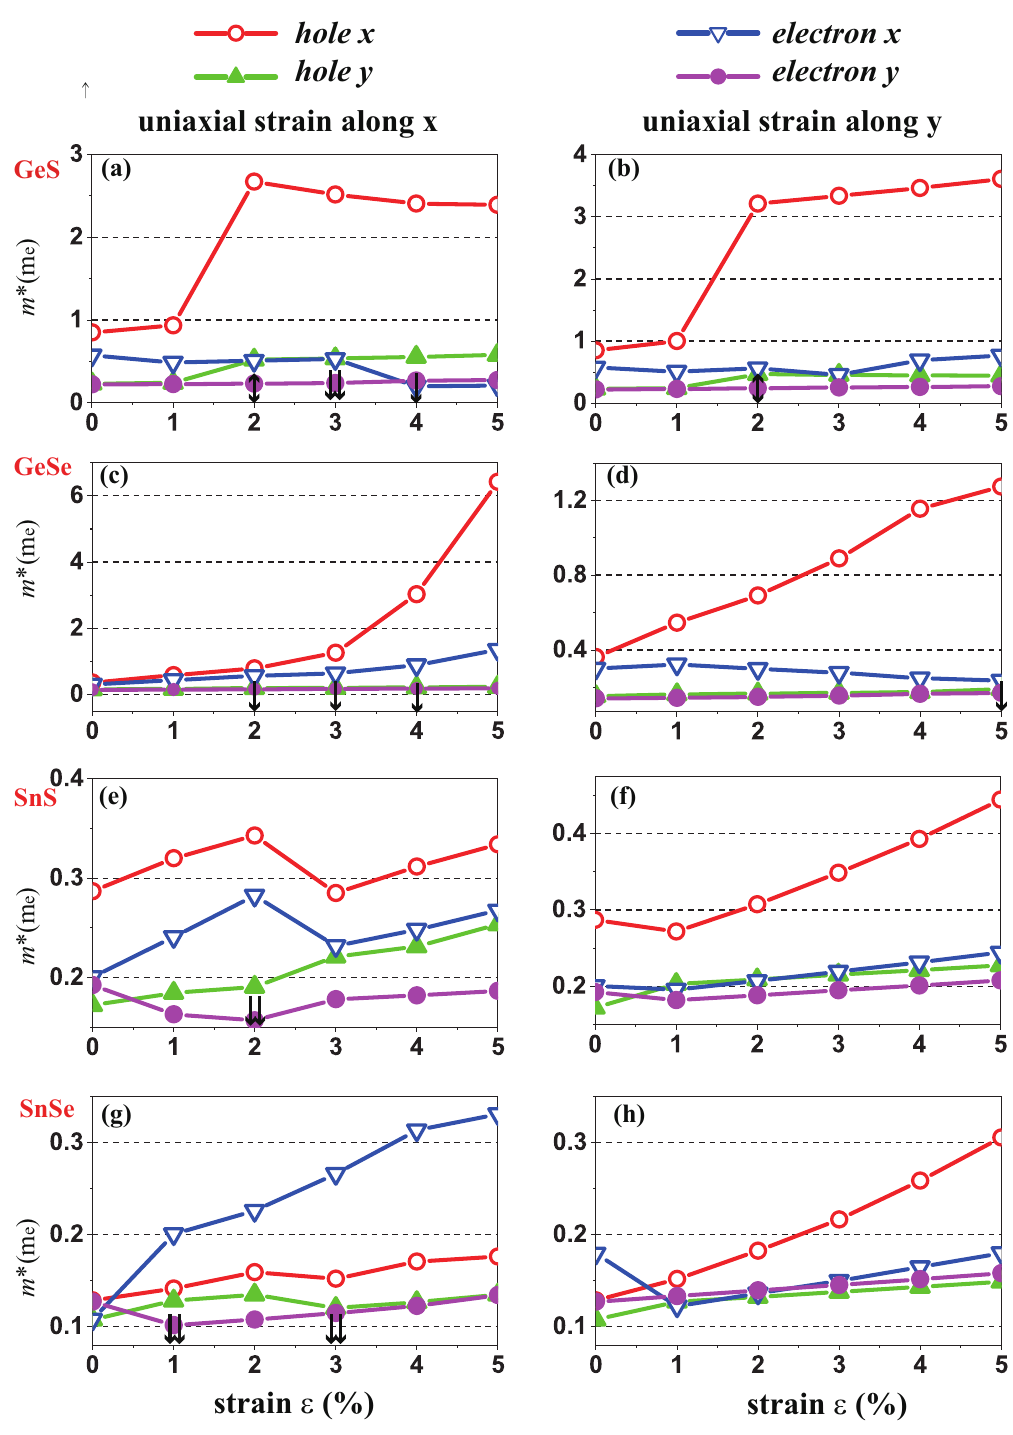
Figure 4. Evolution of carrier effective mass along the x and y directions of monolayer GeS, GeSe, SnS and SnSe under uniaxial strain along x ( a , c , e , g ) and y ( b , d , f , h ) directions,